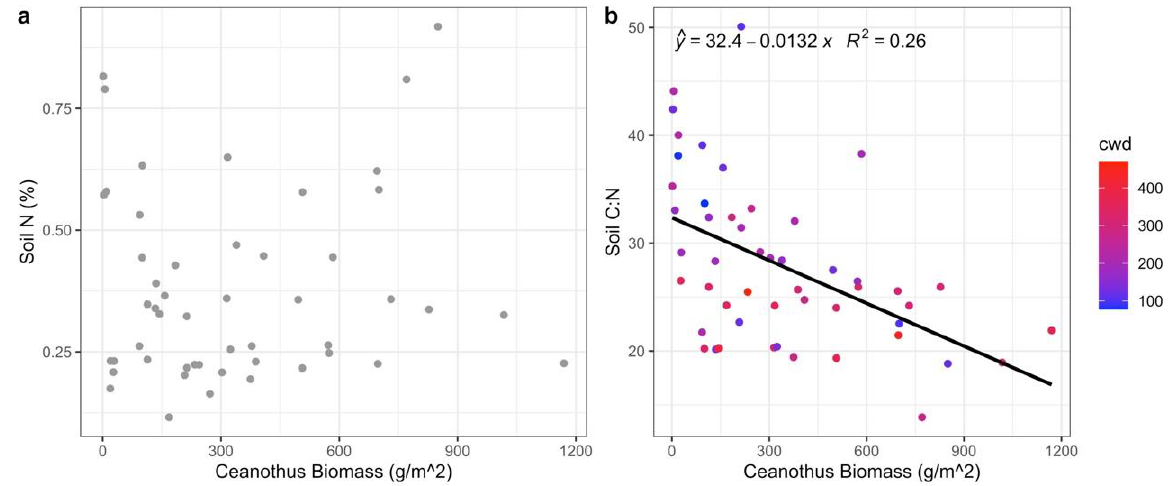
Figure 6. Linear regression of ( a ) Soil N (%) with Ceanothus spp. biomass, ( b ) soil C:N and Ceanothus spp. biomass with climatic water deficit (cwd). Line in ( b ) denotes a significant regression ( p < 0.001), and the relationship remains significant when an interaction with climatic water deficit is considered ( p = 0.002, R 2 = 0.43, not